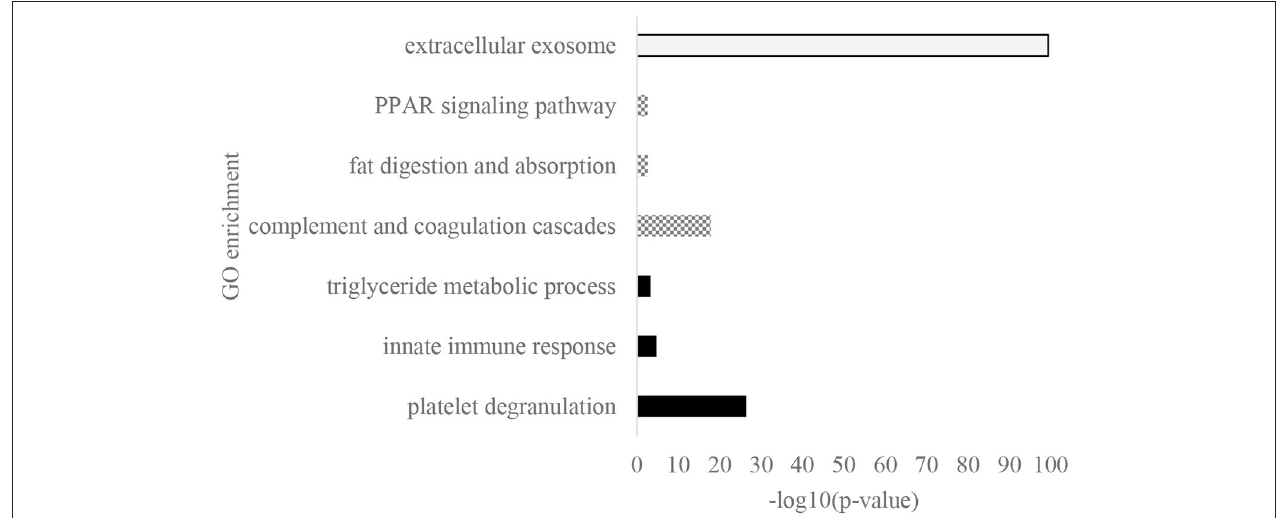
FIGURE 4 | The GO enrichment of significantly different protein across eight cities. White: GO cellular location, dominated by extracellular exosome; Gray: Kyoto Encyclopedia of Genes and Genomes (KEGG) pathways that consisted of complement coagulation cascades, fat digestion and absorption, and Peroxisome proliferator-activated receptors (PPAR) signaling pathway; and Black: GO biological process, dominated by platelet degranulation, innate immune response, and triglyceride metabolic process.